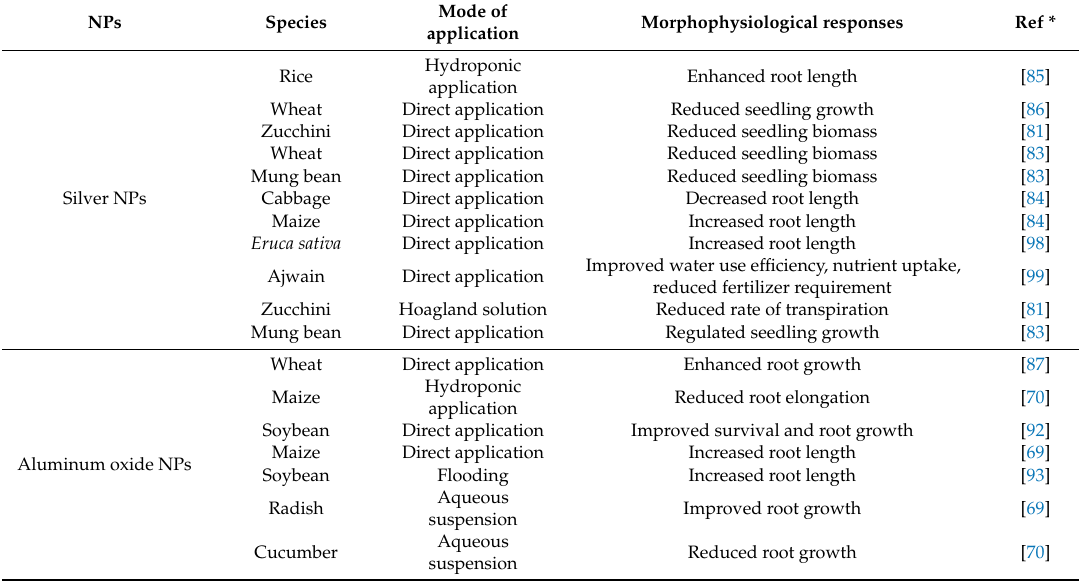
Table 2. Mode of applications and morphophysiological responses of crops upon NPs